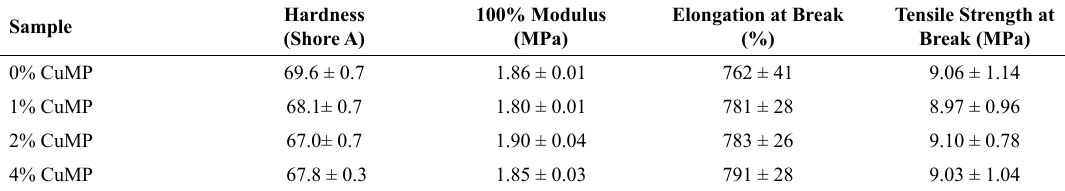
Table 4. Hardness and tensile properties of TPE compounds Sample